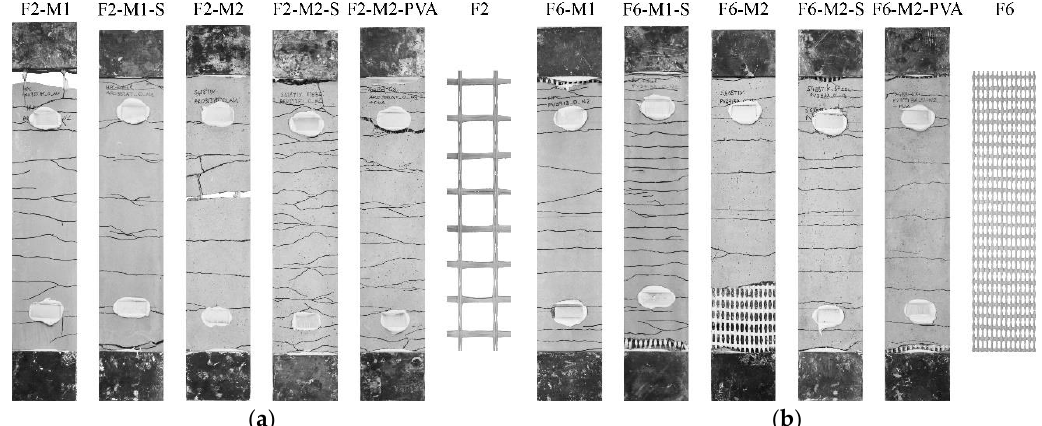
Figure 9. Effect of short fibres addition on the uniaxial tensile response of TRC composites reinforced with Fabrics: F2 ( a ); and F6 ( b ).